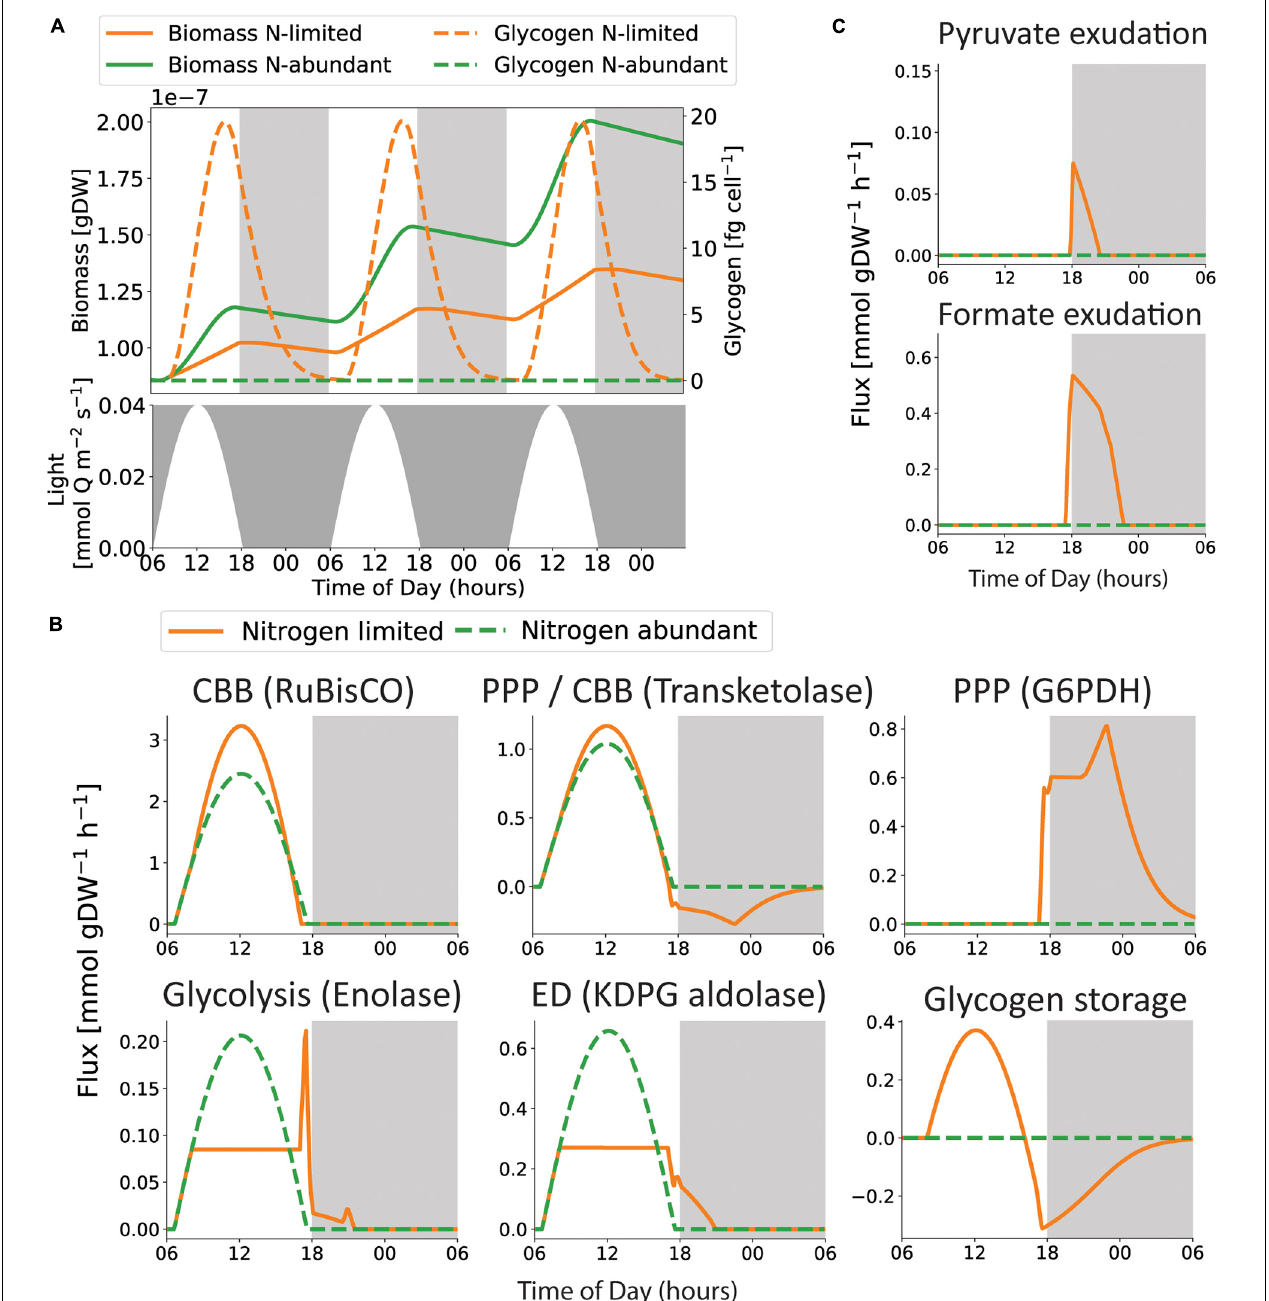
FIGURE 6 | Insight into metabolic rearrangements during the diel cycle. (A) Light irradiance, biomass and glycogen storage throughout the diel cycle. We observe that the largest accumulated growth is found in the nitrogen-abundant condition (green), but glycogen is only predicted to be stored in the nitrogen-poor condition (orange). (B) The flux distributions shifts when the metabolism switches from photosynthesis to glycogen catabolism, displayed by five reactions representing the Calvin Cycle (CBB), Glycogen metabolism, lower part of glycolysis, The Entner–Doudoroff (ED) and the Pentose Phosphate Pathway (PPP). (C) i SO595 predicts that the depletion of glycogen is accompanied by exudation of formate and